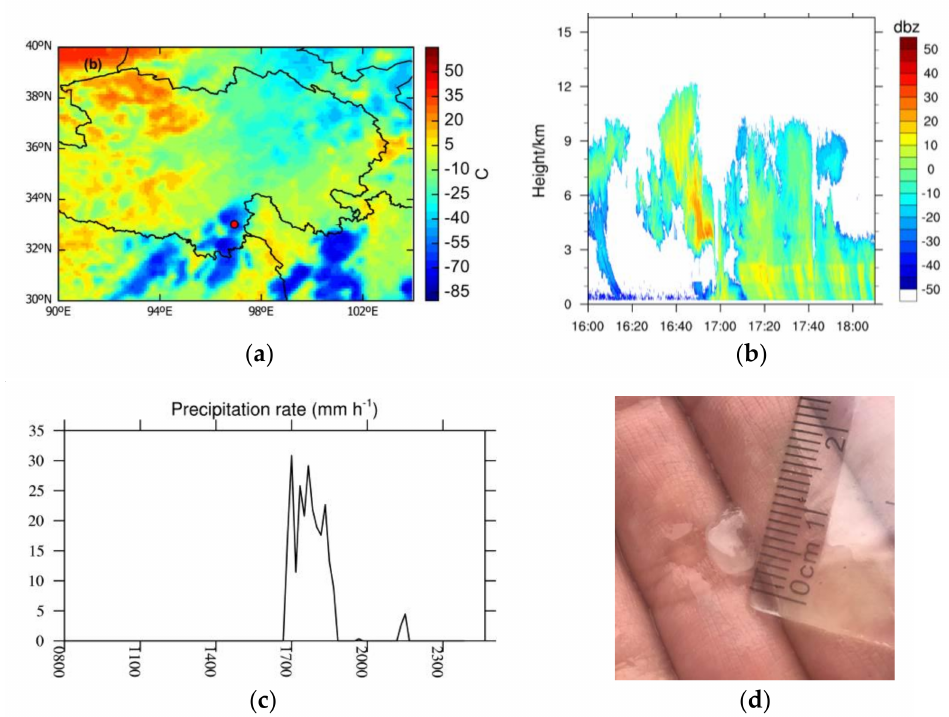
Figure 3. ( a ) The blackbody brightness temperature (TBB) at 17:00 on 11 August 2020, ( b ) the reflec- tivity factor in Yushu, ( c ) the time variation of precipitation intensity in Yushu, and ( d ) photograph of the observed